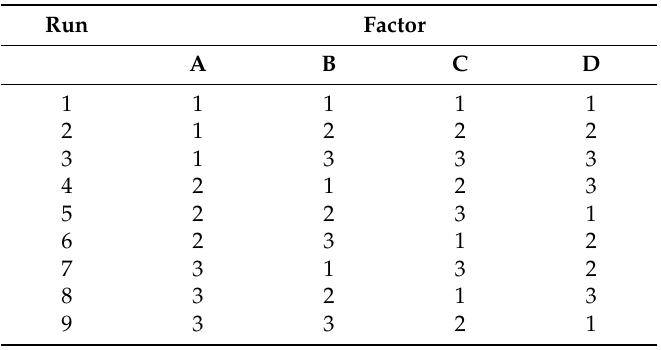
Table 6. Level combination of designed experiments in L 9 (3 4 ) orthogonal array.